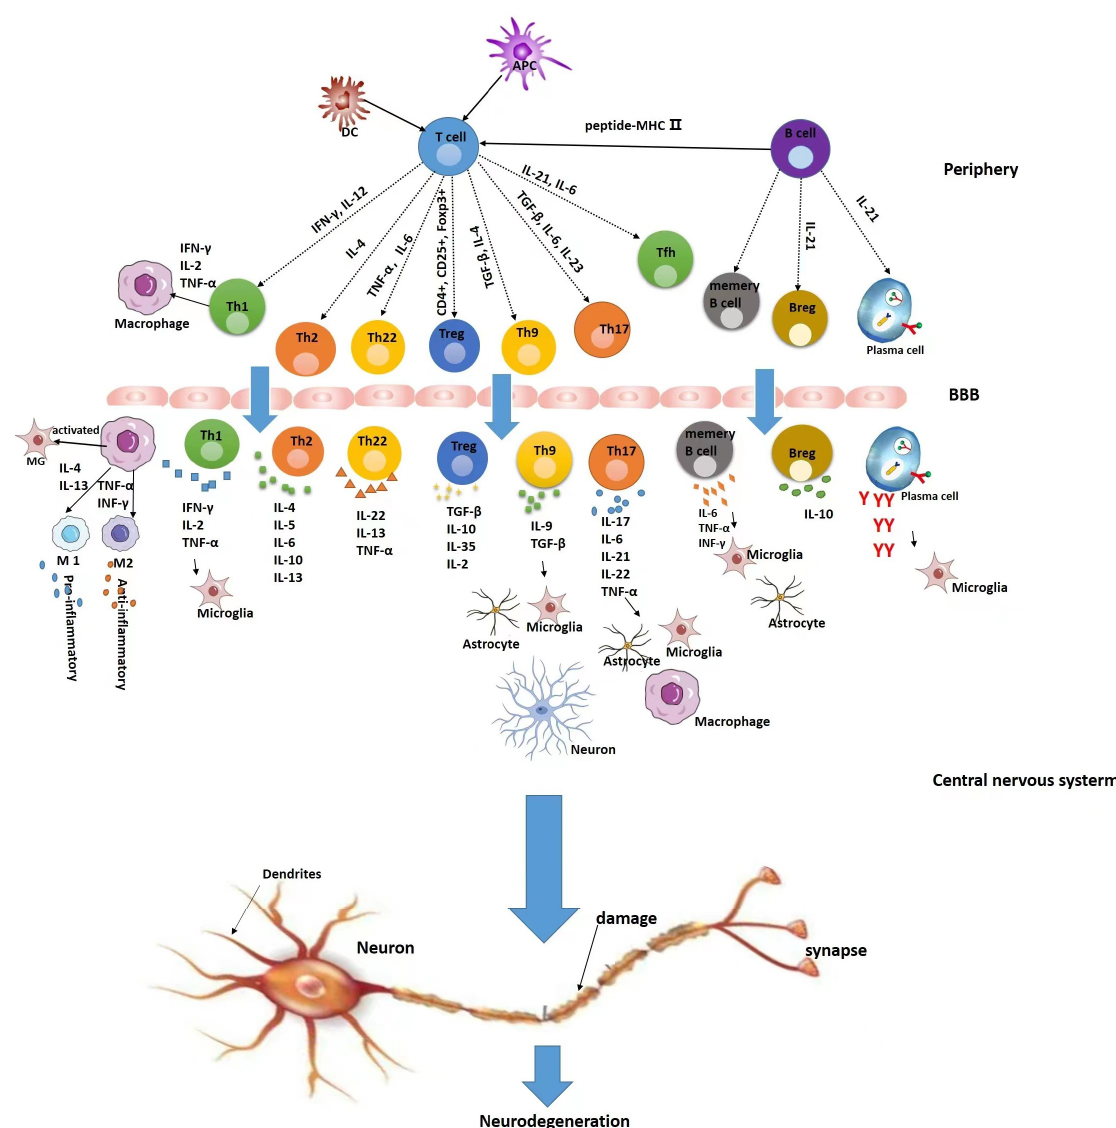
Figure 1. Pathways of action of different immune cells in the pathogenesis of multiple sclerosis.